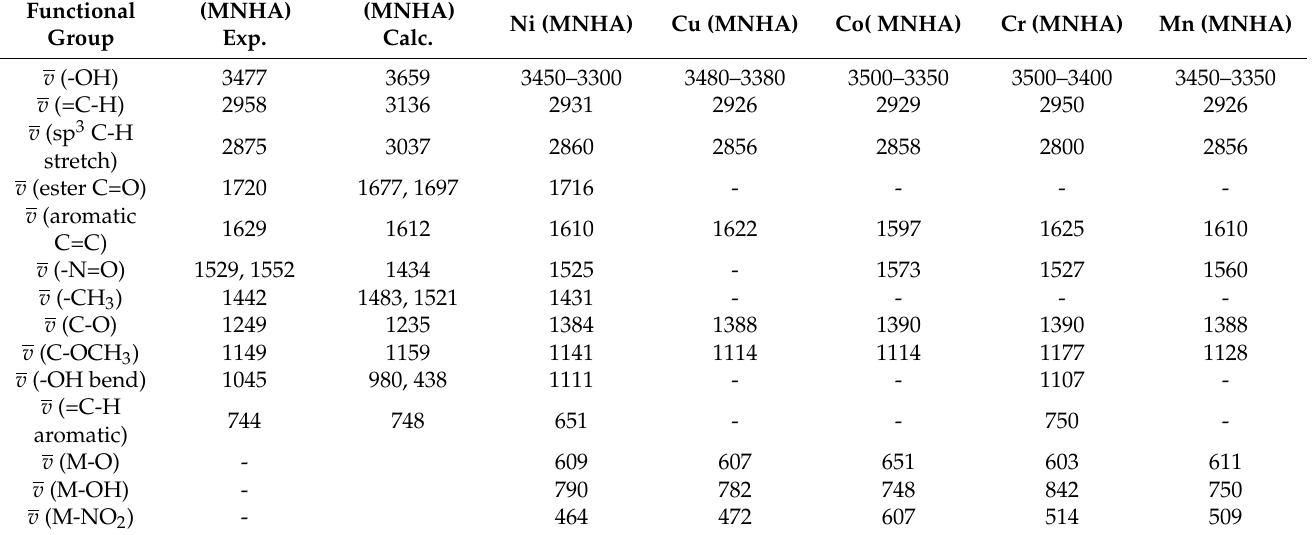
Figure 3. FT-IR overlay patterns of compounds 3–8 . Table 3. Characteristic FT-IR bands ( v = cm − 1 ) of compounds 3–8